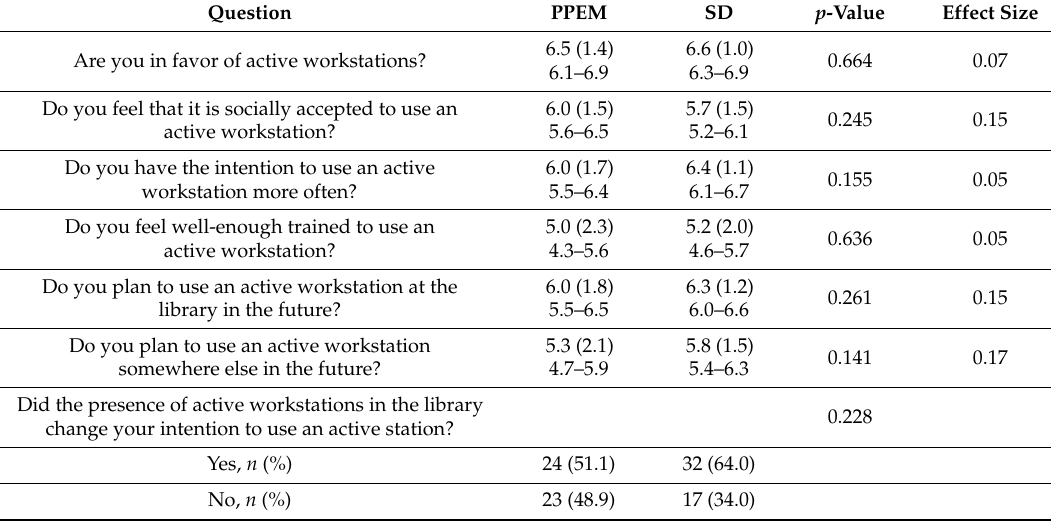
Table 2. Future intent to use an active